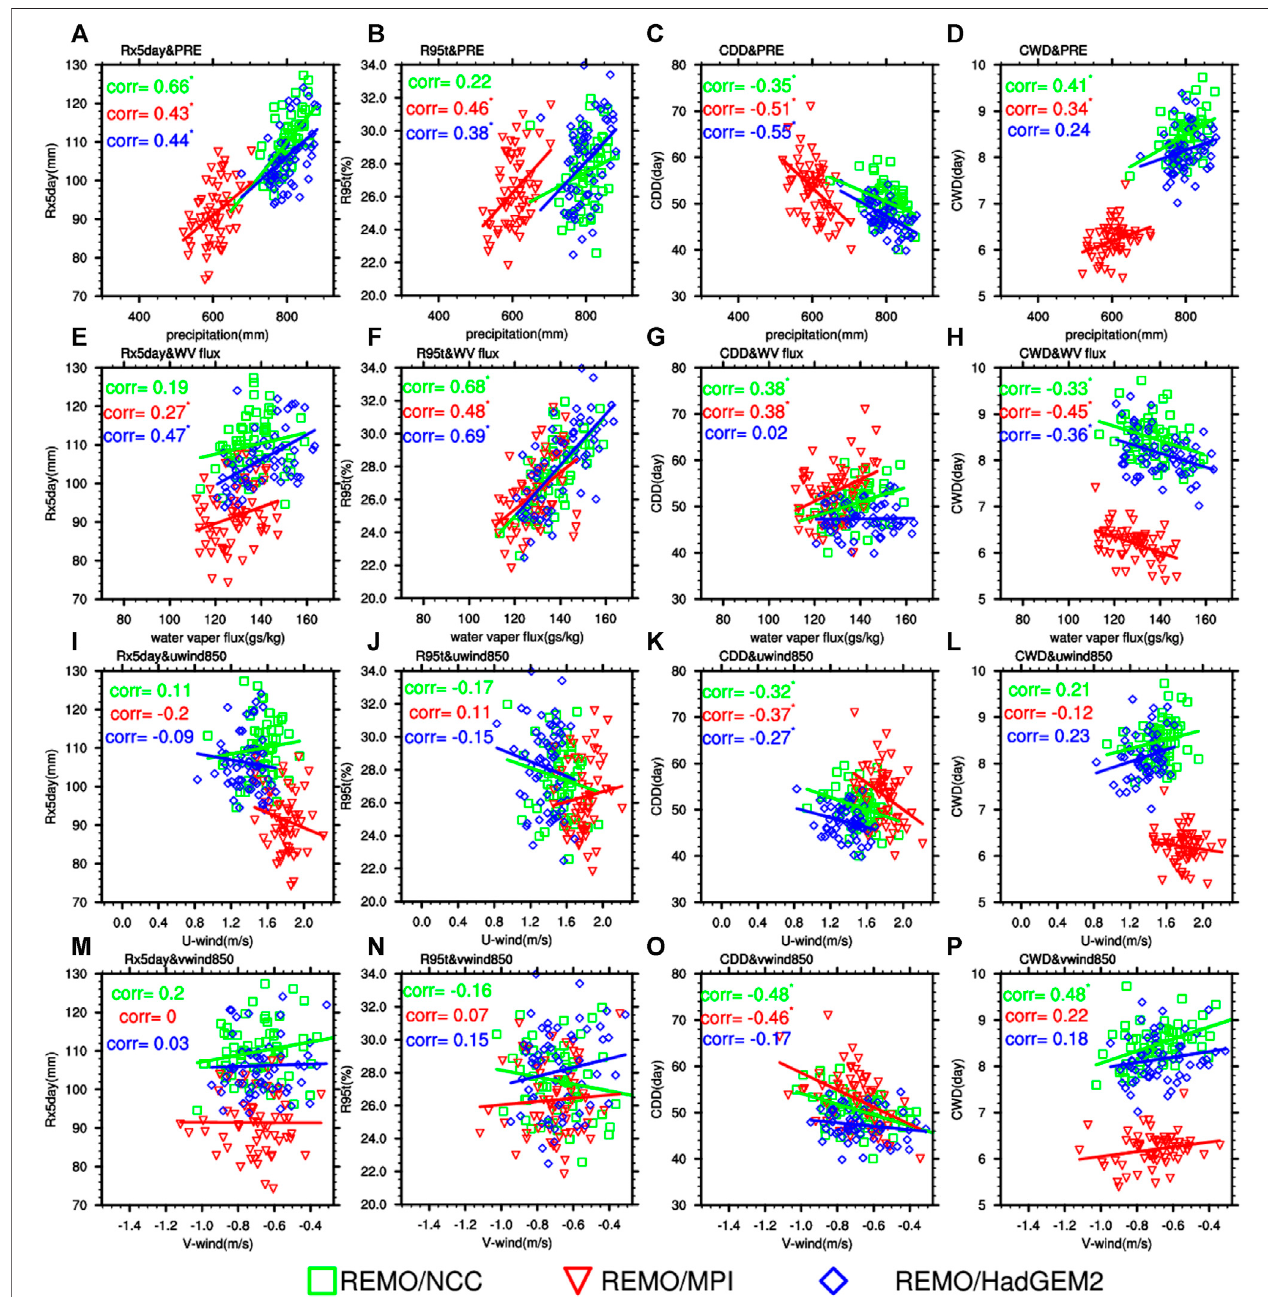
FIGURE 12 | Scatter plots of the extreme precipitation indices against the annual precipitation, the water vapor fl ux and the wind accompanied with the linear regressions. The correlation coef fi cients passing the 0.05 signi fi cance test are asterisked.